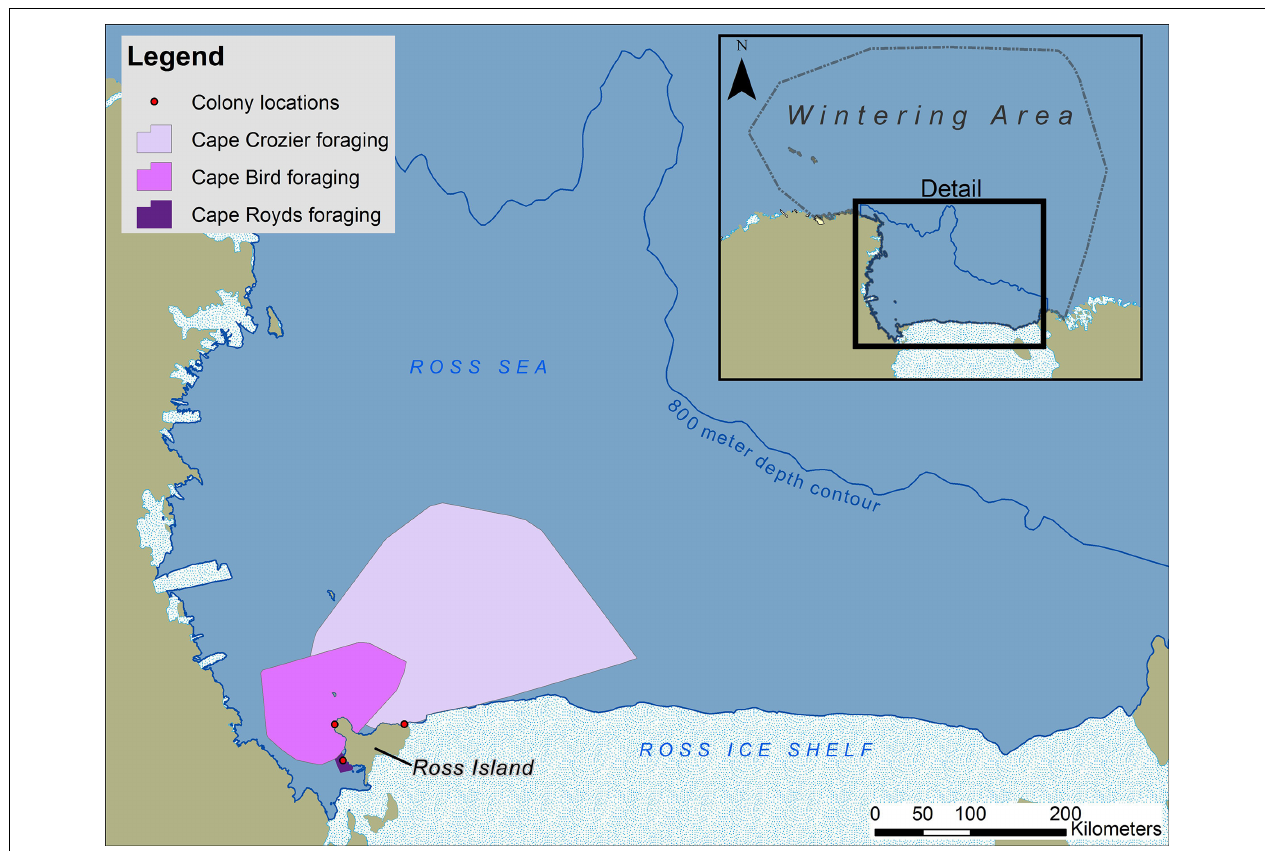
FIGURE 2 | Wintering, migration and foraging areas of Adélie penguins nesting at three colonies on Ross Island Antarctica, during